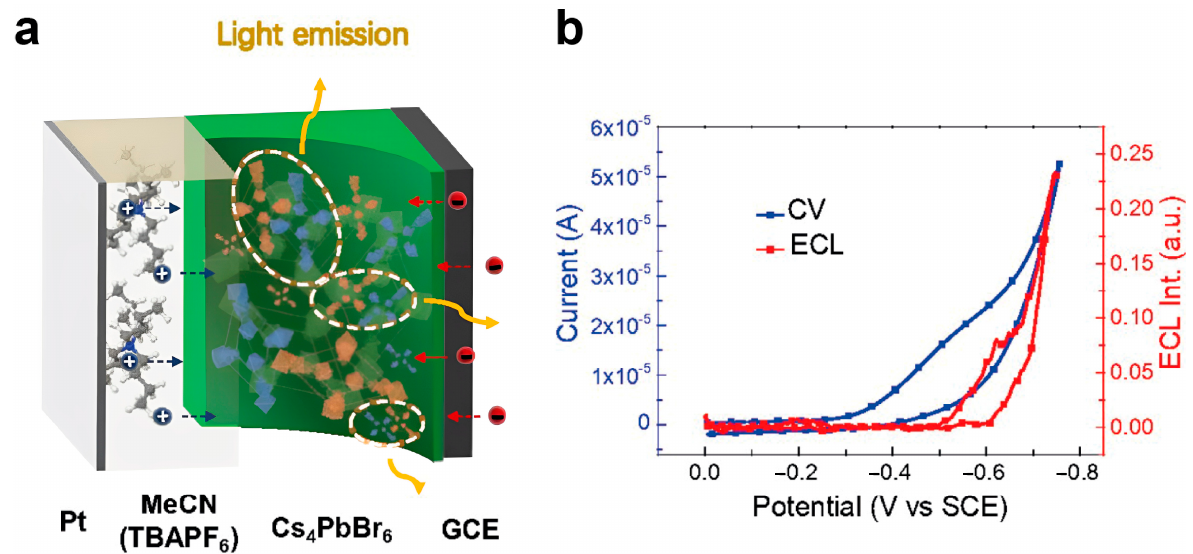
Figure 8. ( a ) Schematic drawing of Cs 4 PbBr 6 /GCE modified electrode and the light generation pro- cess therein. ( b ) ECL (Red curve)—CV (Blue curve) simultaneous measurements of Cs 4 PbBr 6 /GCE in the presence of 50 mM BPO as the coreactant by the pulsing potential from approximately 0.0 V to − 0.75 V. Reproduced with permission from Ref. [24]. © Royal Society of Chemistry.